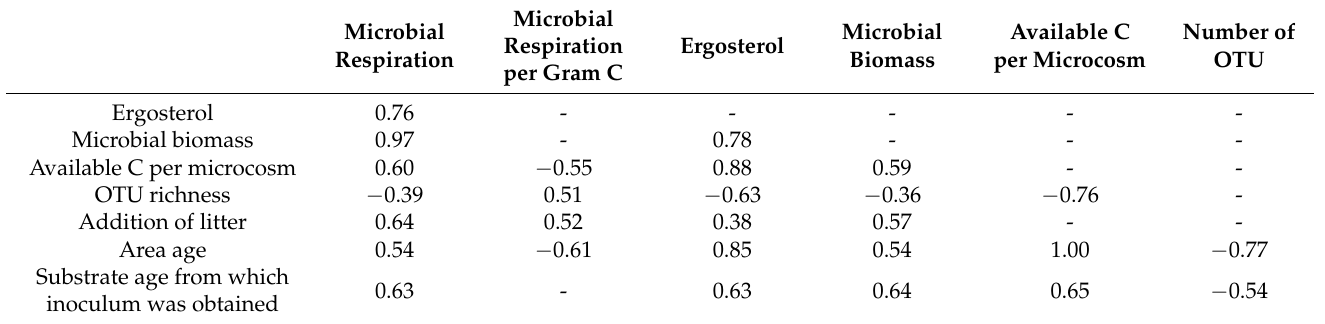
The addition of bushgrass Calamagrostis epigejos L. (Poaceae) litter was coded as 0 (without litter addition) or 1 (with litter addition) and the age of the area as 1 (younger area) or 2 (older area). Only significant correlation coefficients are displayed ( p <